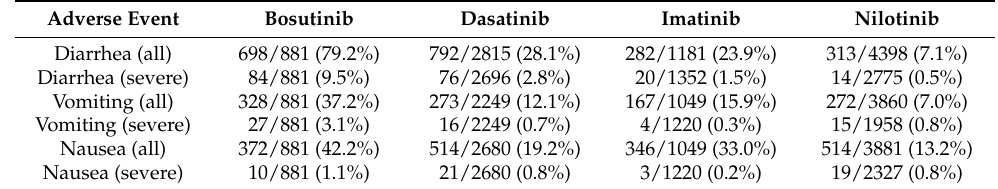
Table 1. Tabulated data for tyrosine kinase inhibitor (TKI) gastrointestinal adverse events (GI AEs) for the meta-analysis of 43 published studies and 10,789 chronic myeloid leukemia (CML) patients.